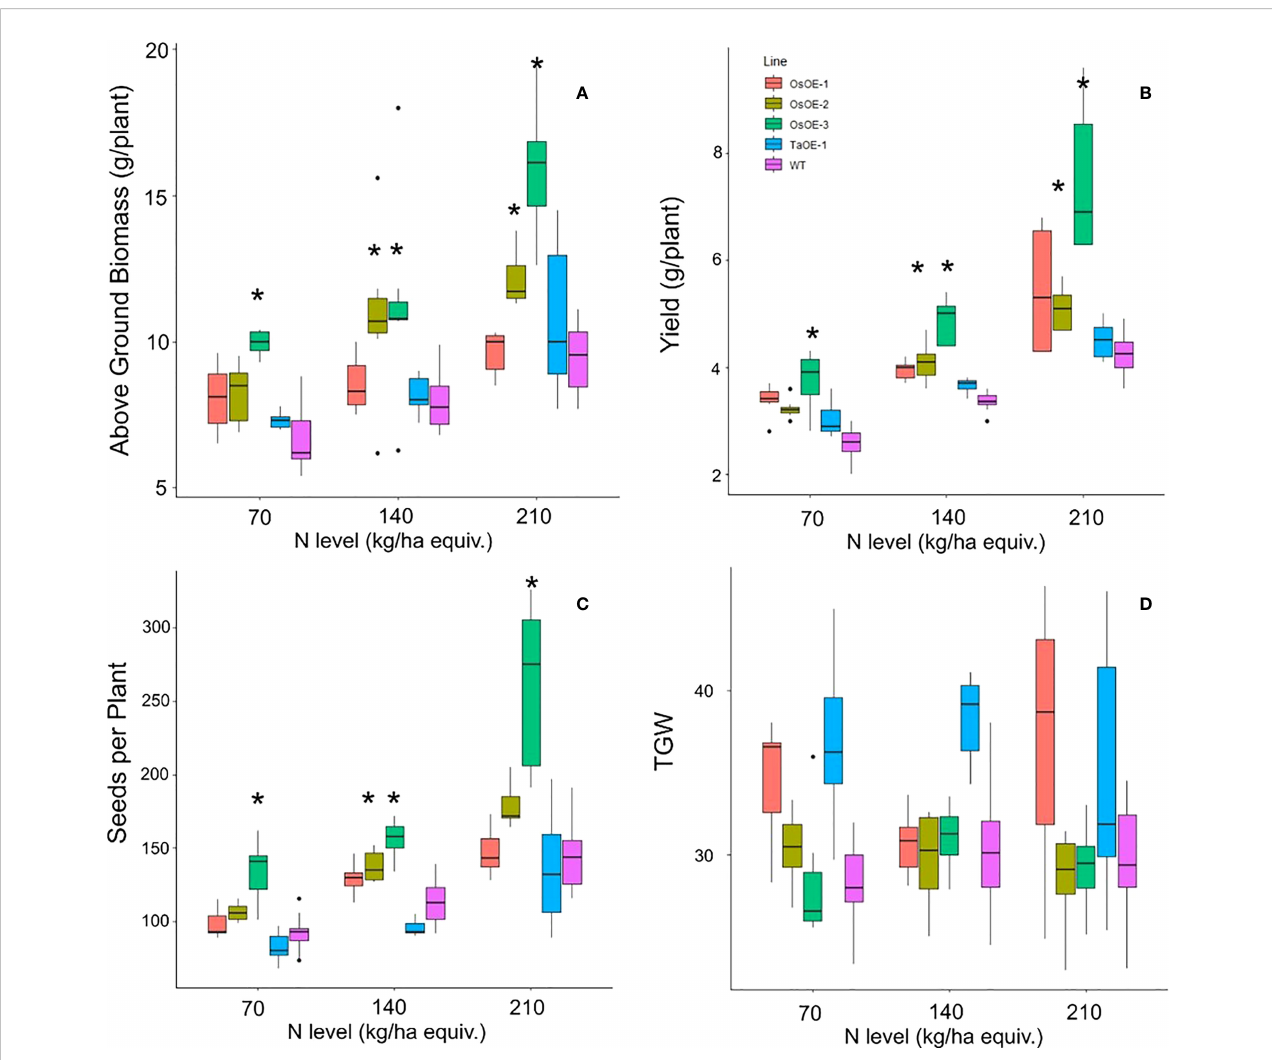
FIGURE 2 Agronomics of Os and TaPSTOL lines grown under a range of N levels. (A) Above ground biomass (B) Yield per plant (C) seeds per plant (D) Thousand Grain Weight (TGW). A star indicates a signi fi cant difference between an overexpression line and WT (pval <